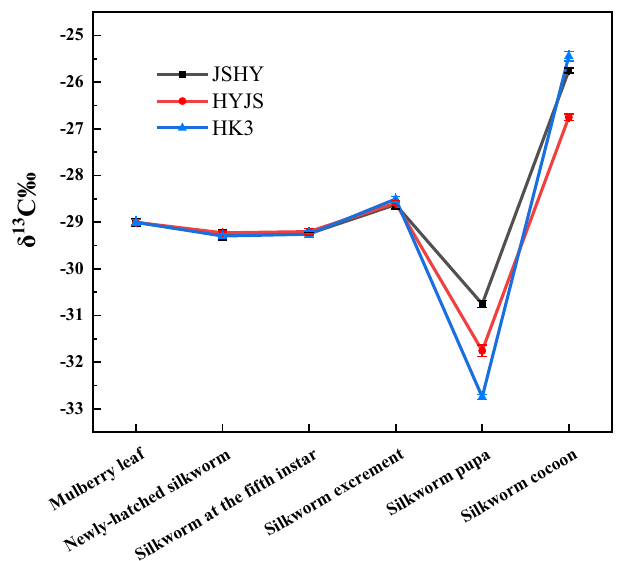
Figure 1. Line chart of carbon stable isotope ratios in samples.